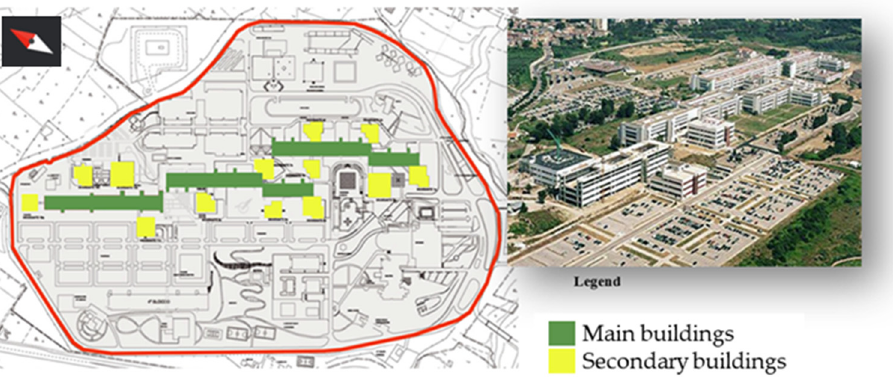
Figure 1. General Plane of Campus of Fisciano with identification of main buildings and second- ary buildings. ondary